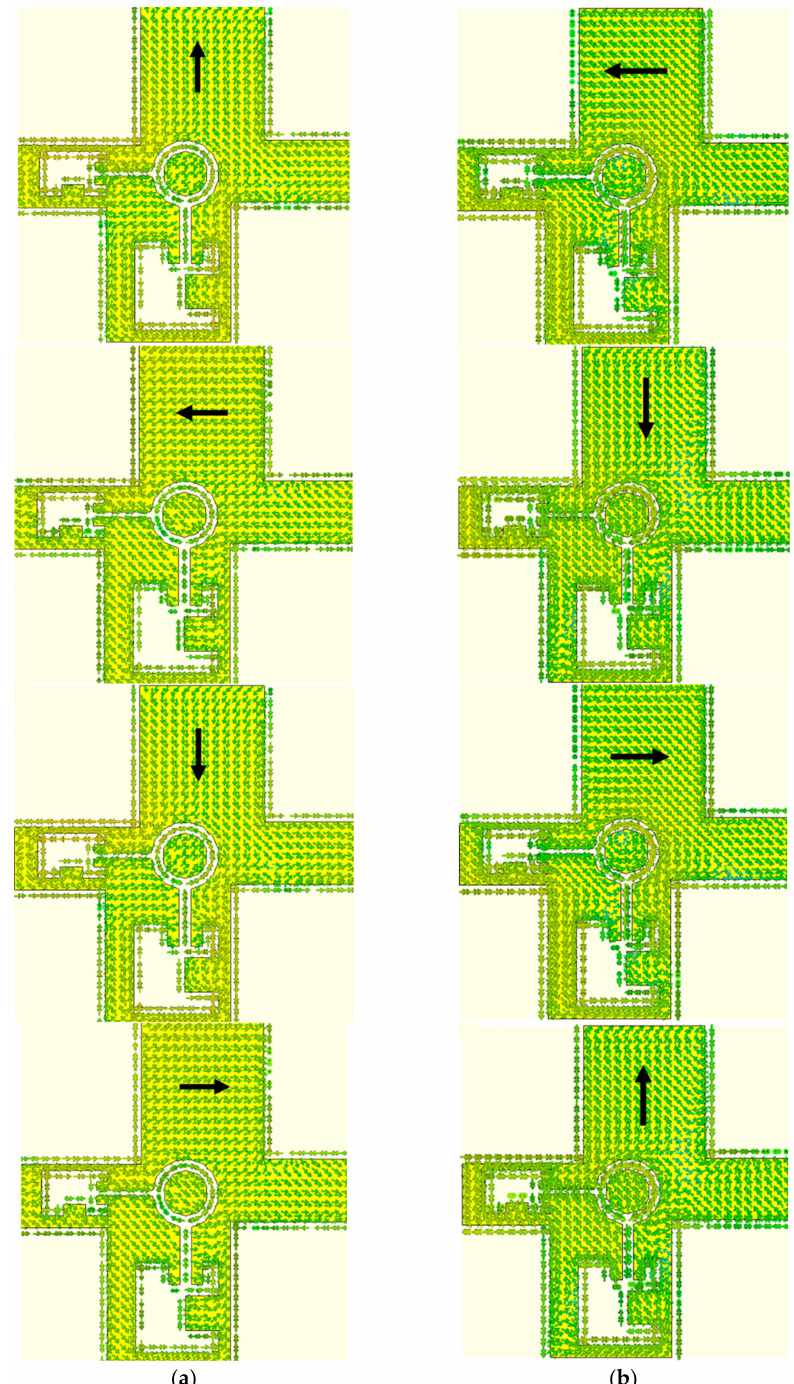
Figure 5. Surface current distribution of proposed antenna at 1.5 GHz and 2.6 GHz. ( a ) 1.5 GHz, ( b ) 2.6